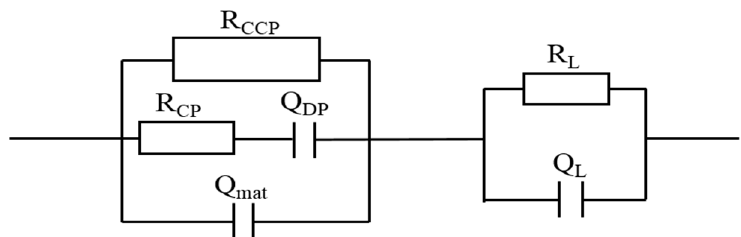
Figure 9. Equivalent circuit model for calcium leaching of cement composites, where R CCP is the resistance of the CCPs in the intact zone; Q DP is the double layer capacitance of the DCPs in the intact zone; R CP is the resistance of the DCPs in the intact zone; Q mat is the double layer capacitance of the ICPs in the intact zone; R L is the resistance of the CCPs in the degraded zone; and Q L is the double layer capacitance of the ICPs in the degraded zone.